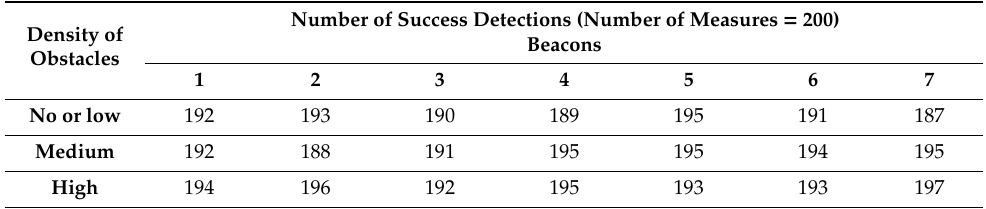
Table 4. Number of correct detections of transmitters in relation to the density of physical obstacles. Density of Obstacles